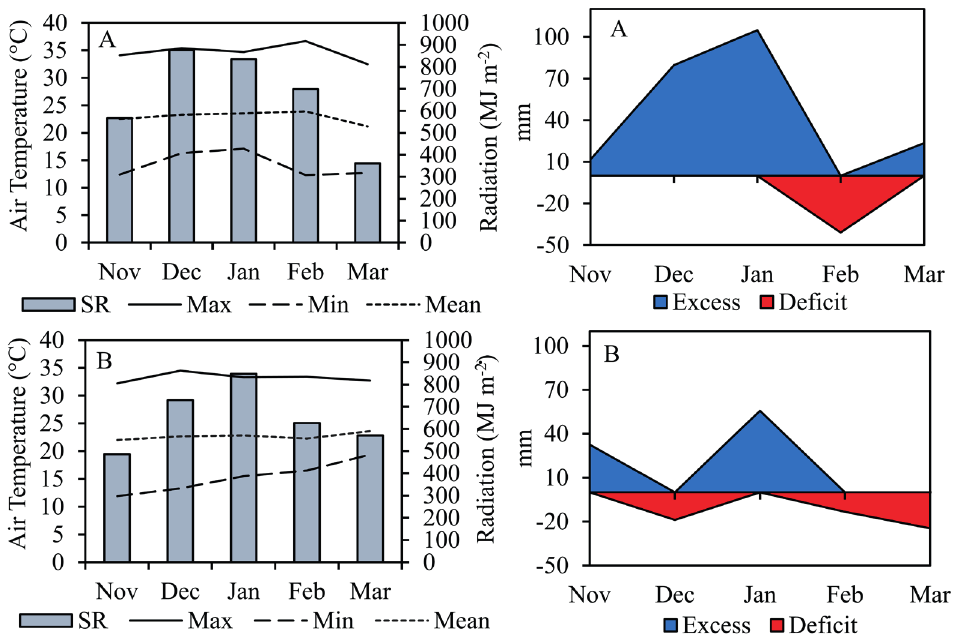
Figure 3 - Monthly averages of minimum, maximum and average air temperatures, accumulated incident solar radiation, and water balance during the experimental period in Frederico Westphalen, Brazil, ‘A’ –